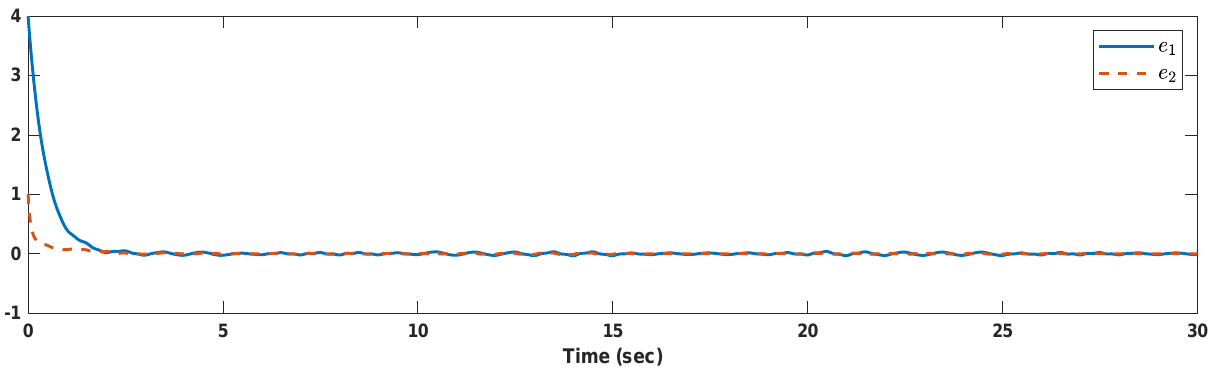
Figure 10. Example 2: Time response of the estimation error.